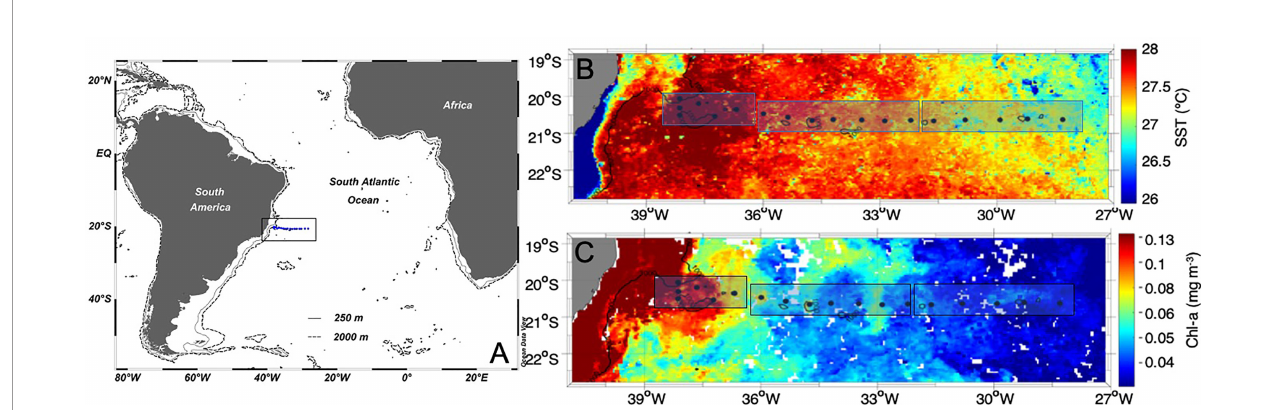
FIGURE 1 | (A) Map of the South Atlantic Ocean and the study area (black rectangle). The blue dots indicate the locations of the sampling stations. (B) Sea surface temperature average (°C) from two 8-day composite images of MODIS-Aqua (4 km) (February 2 – 17, 2017). (C) Chlorophyll- a concentration average (mg m -3 ) from two 8-day composite images of MODIS-Aqua (L3, 4 km) (February 2 – 17, 2017). The black rectangles indicate the three sectors (West, Middle, and East) derived from a hierarchical cluster analysis of the physical